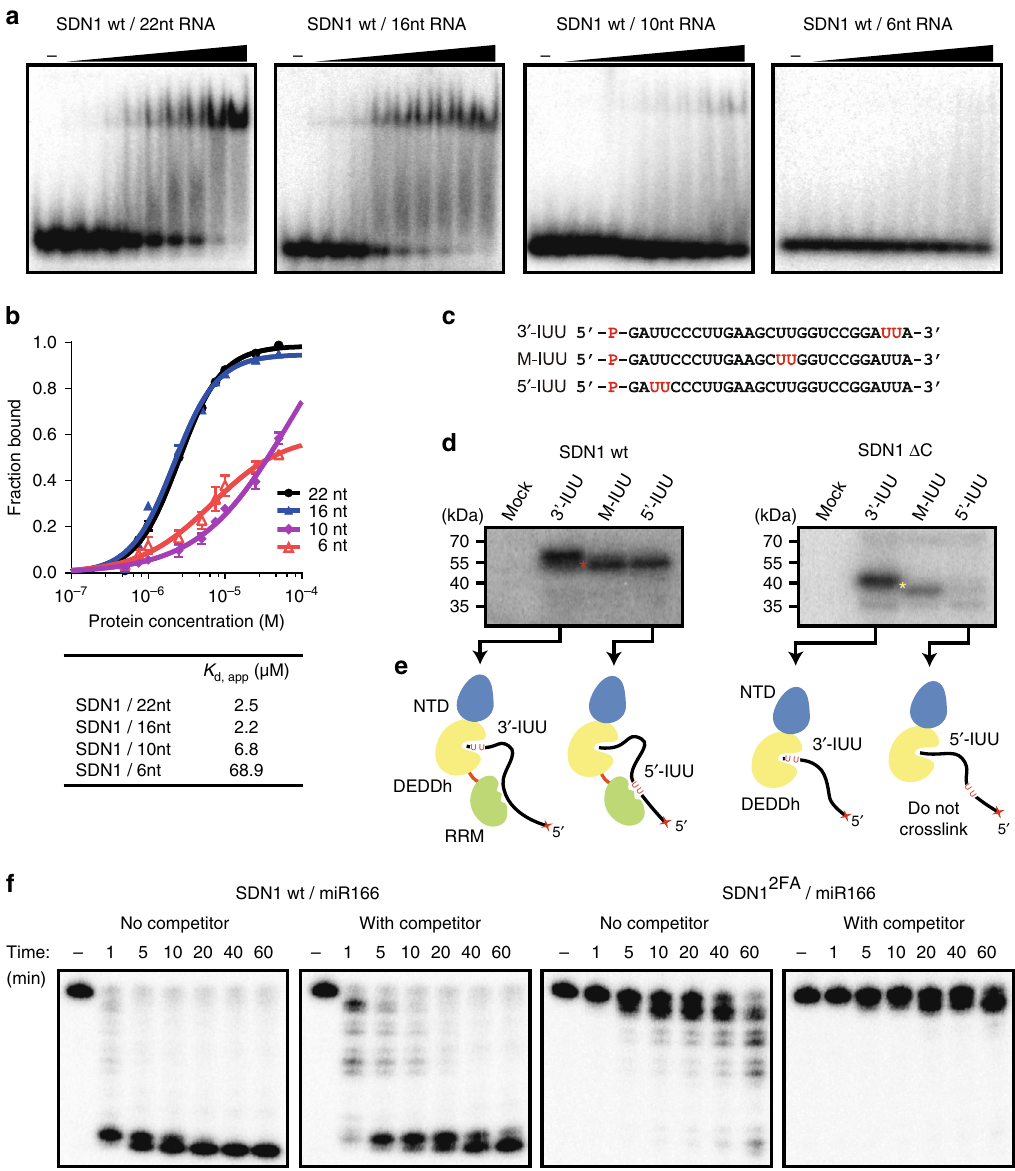
Fig. 4 The CTD RRM domain is critical for SDN1 binding and enzymatic activities on ssRNA. a EMSA assays of wild-type SDN1 with 22 nt, 16 nt, 10 nt or 6 nt ssRNA substrates. Assays were conducted at a series of protein concentrations: 0.5 µ M, 0.75 µ M, 1 µ M, 2.5 µ M, 5 µ M, 7.5 µ M, 10 µ M, 25 µ M, and 50 µ M (from left to right). No Mg 2 + was included to prevent catalytic activity. b Plots showing the RNA fractions bound at varying protein concentrations. The fractions bound were calculated from the densities of the free RNA bands in a . Scale bars represent standard deviations calculated from three biological replicates. c Diagram of 5-iodoU-substituted ssRNAs used in SDN1 UV crosslinking assays. 5-iodoUs are shown in red in the sequences. d UV crosslinking assays of wild-type SDN1 or SDN1 Δ C with ssRNAs shown in c . The red and yellow asterisks indicate full-length SDN1 crosslinked to RNA and SDN1 Δ C crosslinked to RNA, respectively. e Diagrams of how SDN1 or SDN1 Δ C was crosslinked to different 5-iodoU ssRNAs. f Enzymatic assays of wild-type SDN1 or SDN1 2FA with or without cold RNA competitor. The labeled RNAs were fi rst incubated with the enzymes to allow for binding but not catalysis, then Mg 2 + or a mixture of Mg 2 + and cold RNAs was added to initiate the reactions. The time indicated above each lane represents the elapsed time from the time Mg 2 + was TEV cleavage site inserted between the DEDDh and the RRM (Fig. 5g). These results strongly support our model of how SDN1 domains (residues: 300-ENLYFQ/S-301; Fig. 5f), and TEV may recognize a miRNA/target mRNA duplex, in which the cleavage was performed after UV crosslinking, so that the SDN1 DEDDh domain binds the 3 ′ end of the miRNA while the domain crosslinked to the RNA could be determined on an SDS- RRM domain binds the 5 ′ region of the target mRNA (Fig. 5e). PAGE gel based on the size of the crosslinked protein-RNA complex (Fig. 5e). For the miR166:5 ′ -IUU RNA duplex, the band after digestion matched the size of the RRM domain plus RNA, SDN1 binds AGO PAZ and trims the 3 ′ ends of AGO-bound while for the miR166:3 ′ -IUU RNA duplex, the band after miRNAs . Mature miRNAs are mostly associated with AGO1 digestion matched the size of the DEDDh domain plus RNA in vivo and can undergo 3 ′ trimming by SDN1 in vitro while